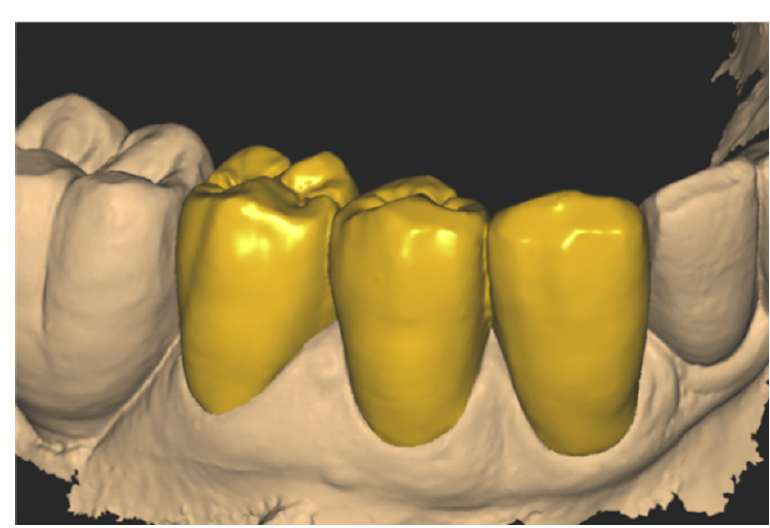
Figure 16. Modelling the zirconia crowns.